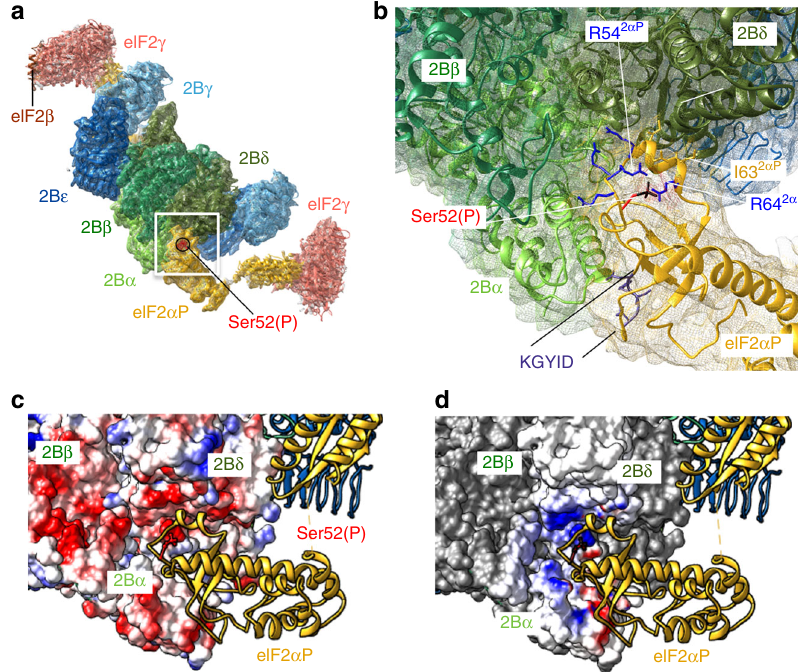
Fig. 3 eIF2 α N-terminal domain binds between the eIF2B α and δ subunits. a Overview and b detail of eIF2 α P molecular interactions with eIF2B, showing the electron cryomicroscopy (cryoEM) density as a mesh and highlighting a network of arginines around Ser52 and the KGYID sequence. c , d Complimentary surface potentials at the eIF2 α P/eIF2B interface. c Electrostatic surface representation of eIF2B αβδ and d Coulombic potential due to eIF2 α P displayed at the eIF2B αβδ surface. Blue, positive and red,